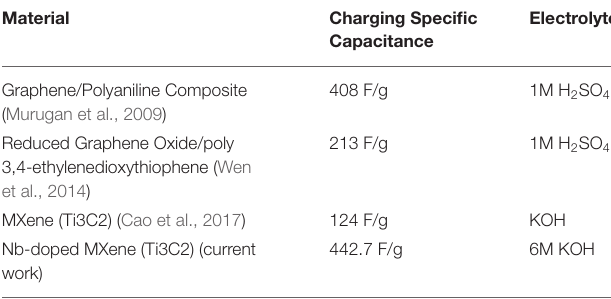
TABLE 1 | Comparison of specific capacitance of two-dimensional materials. Material Charging Specific